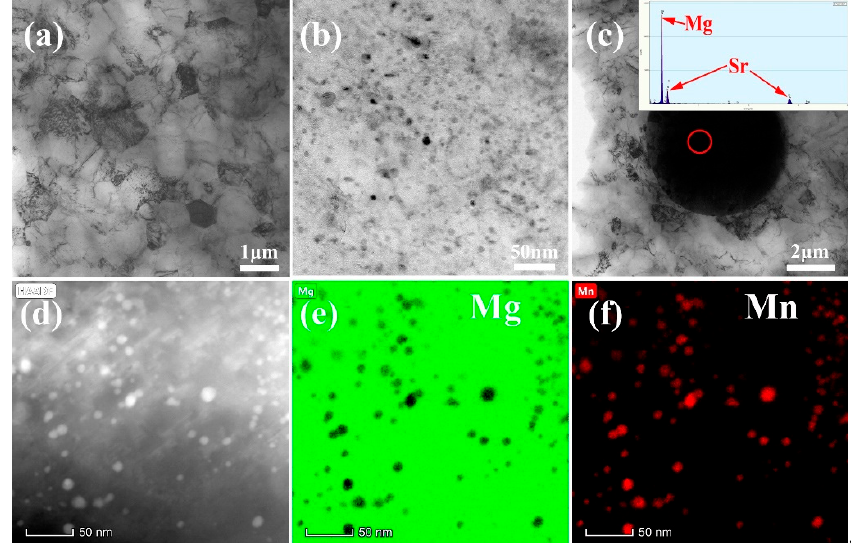
Figure 5. TEM micrographs of the of the as-extruded Mg-0.5 wt.% Sr-2 wt.% Mn alloy. ( a ) and ( b ) Bright field (BF) image; ( c ) BF and EDS results of second phase Mg17Sr2; ( d – f ) High Angle Annular Dark Field Imaging (HAADF) with EDS mapping.